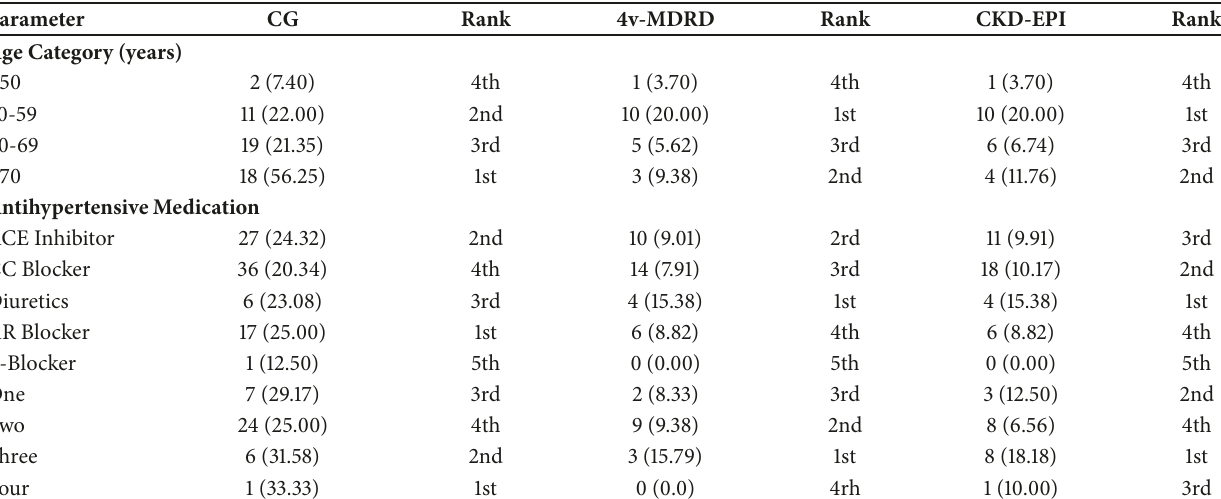
Table 6: Prevalence of renal dysfunction stratified by age and